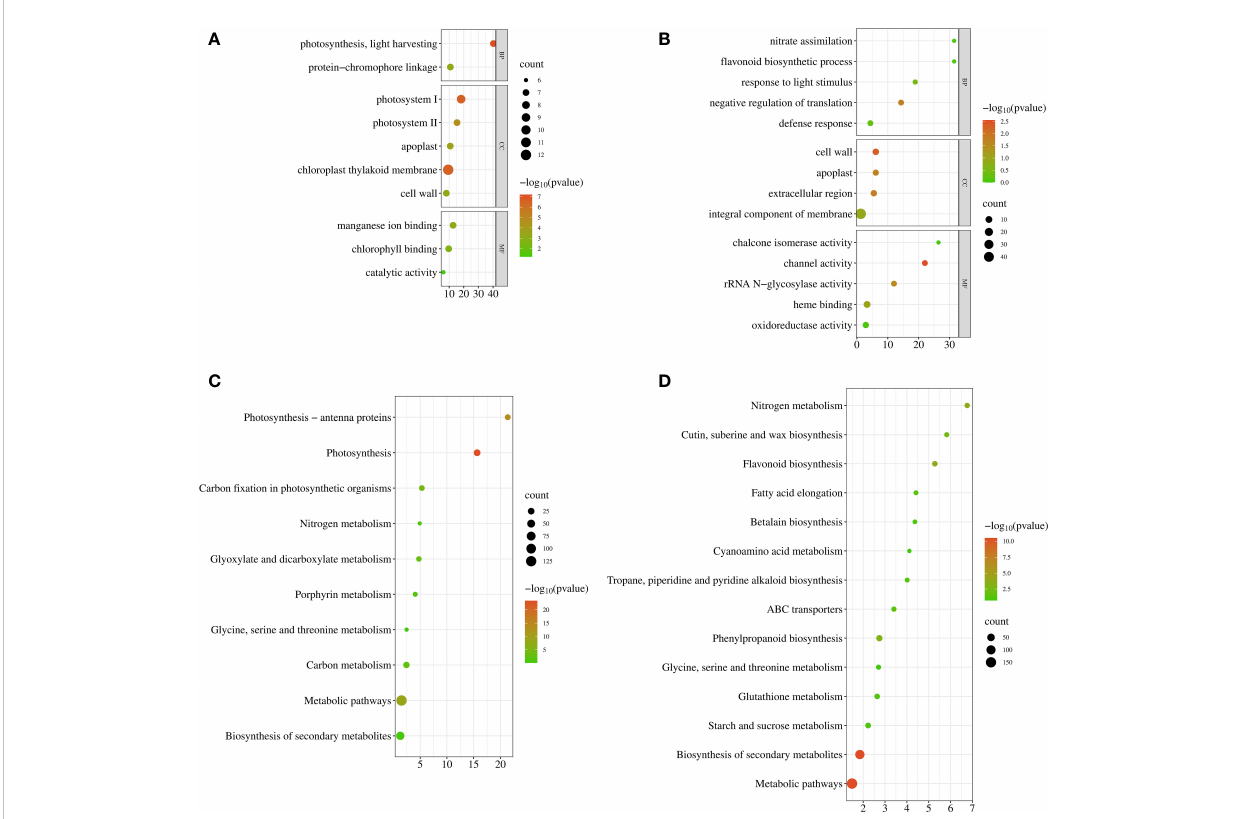
FIGURE 4 Functional enrichment of DEGs of sugar beet under low N stress. (A, B) Scatter plot of GO functional enrichment in leaves and roots. (C, D) Scatter plot of KEGG enrichment in leaves and roots. The x-axis is the enrichment factor; the y-axis is the enrichment of entries. The size of the bubbles represents the number of DEGs on the annotated items; the color represents the enrichment degree − log 10(p-value) . DEGs, differentially expressed genes; GO, Gene Ontology; KEGG, Kyoto Encyclopedia of Genes and